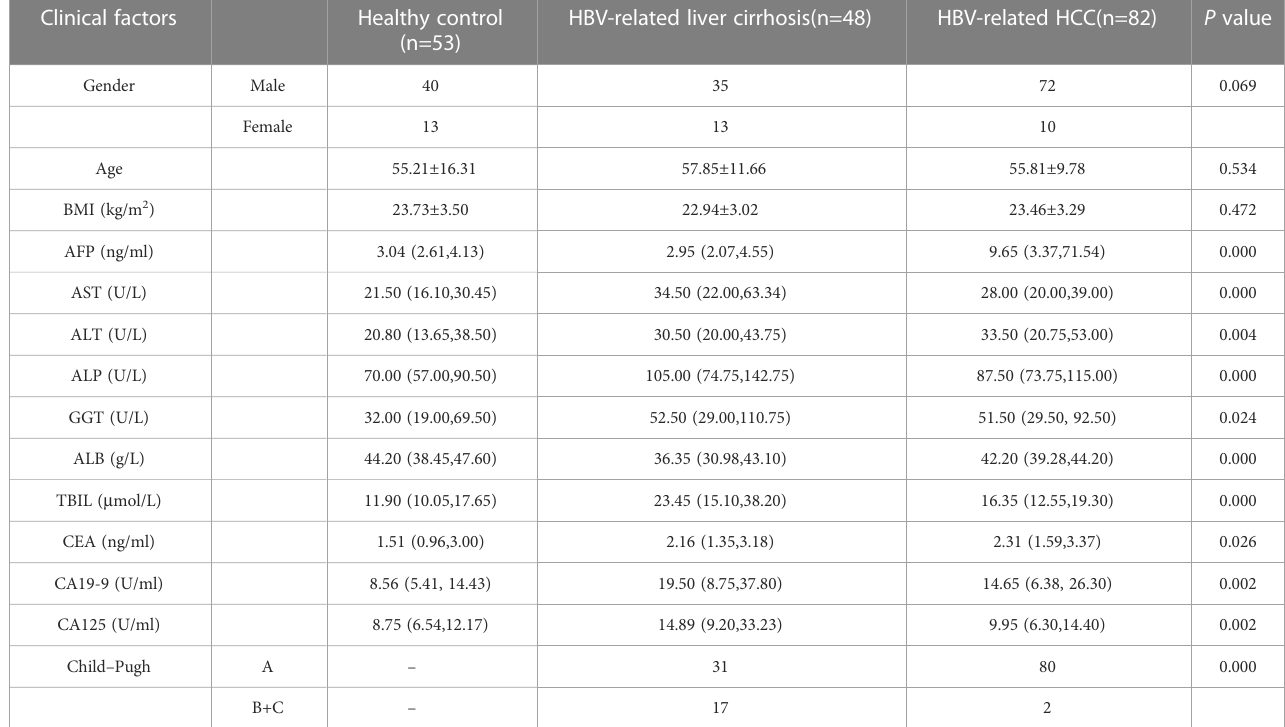
TABLE 4 The clinical data of patients.